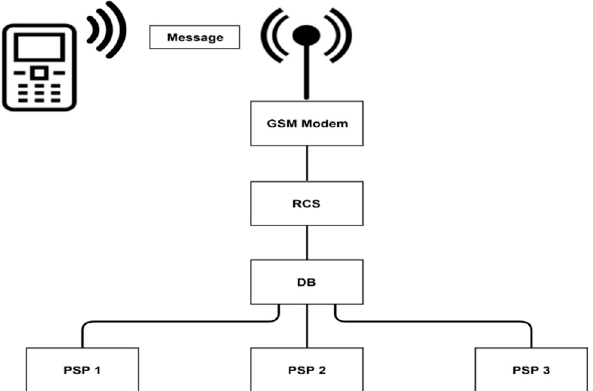
Figure 5. Diagram of the command system of resistive heating of railway switches using GSM networking. RCS = remote control system; DB = distribution block; PSP = power supply panel. The 40-pin, 8-bit PIC16F887 microcontroller (Microchip, Chandler, AZ, USA), uses